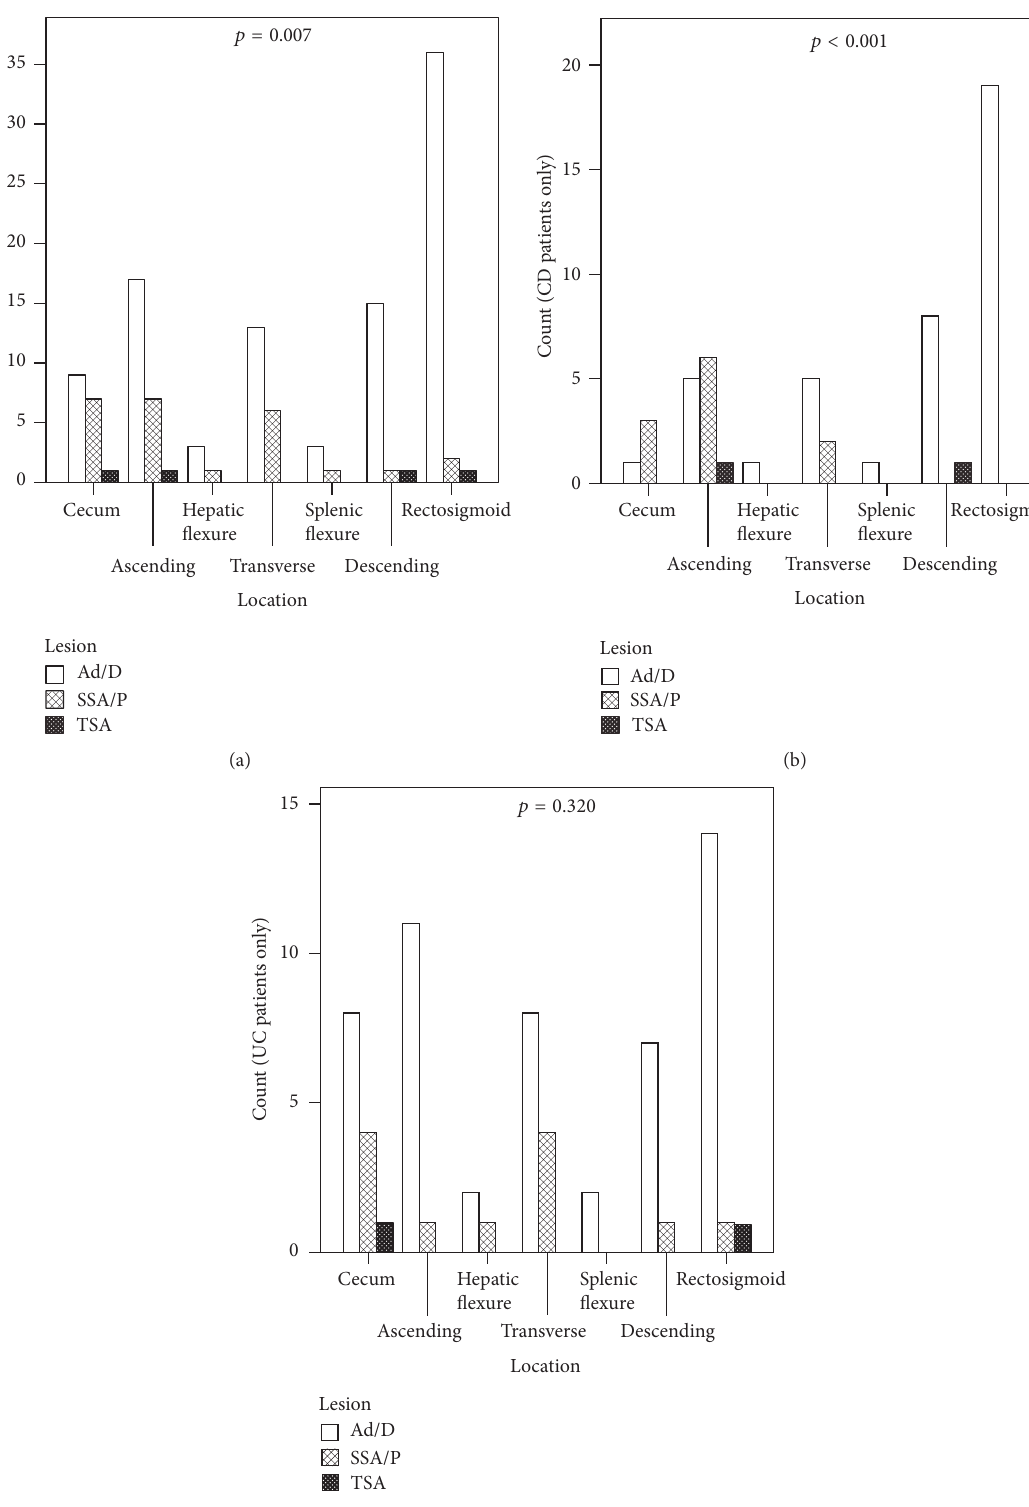
Figure 2: Anatomical distribution of conventional adenomas/dysplasia (Ad/Ds), sessile serrated adenoma or polyps (SSA/Ps), and traditional serrated adenomas (TSAs) for (a) all patients studied, (b) patients with Crohn’s disease, and (c) patients with ulcerative colitis. 𝑝 values are for the comparison between Ad/Ds and